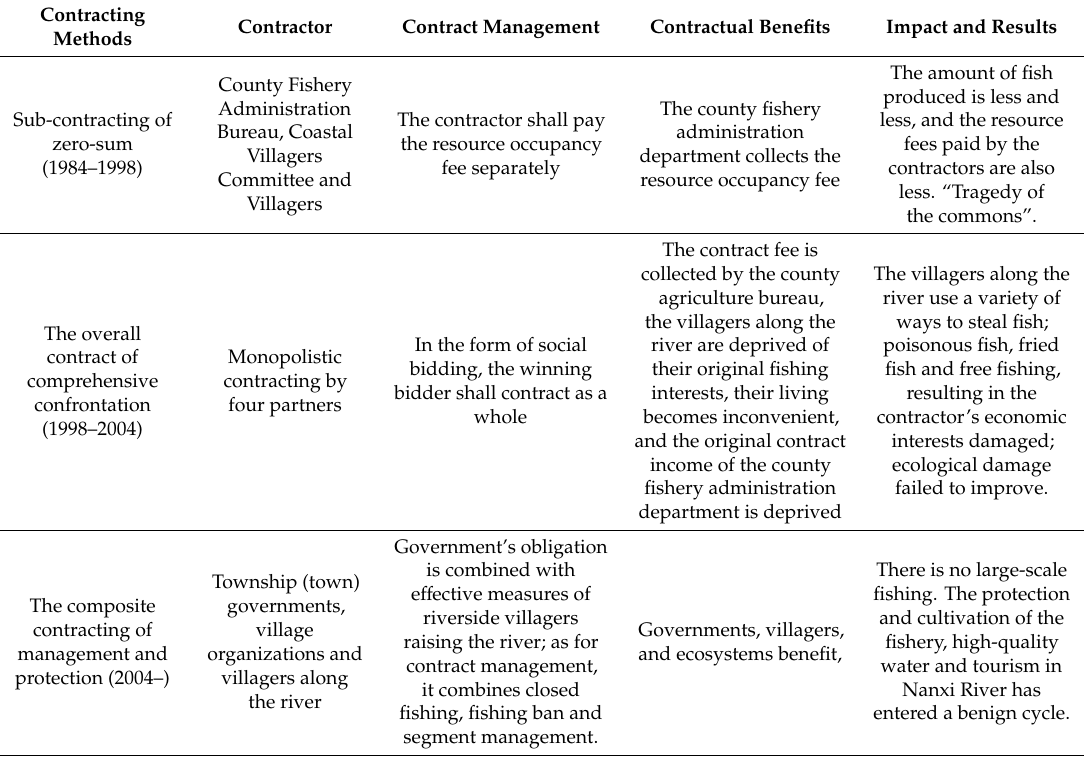
Table 1. Di ff erences between the fishery